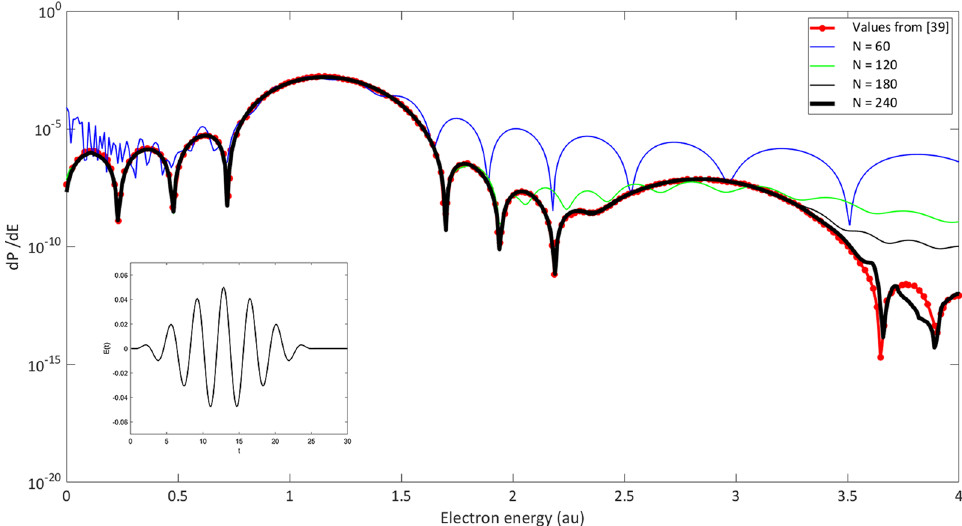
Figure 1. Ionization spektrum of H after irradiation with a linear polarized few cycle pulse. The electric field of the pulse is depicted in the inlay, the pulse parameters are E ( t ) T f 0.05 . Thick black solid curve (N=240): this work; red dotted curve: results from [39]. The thin 25.72 , E 0 = = 60 ), green ( N 120 ) and black ( N curves in blue ( N = = parameter N in